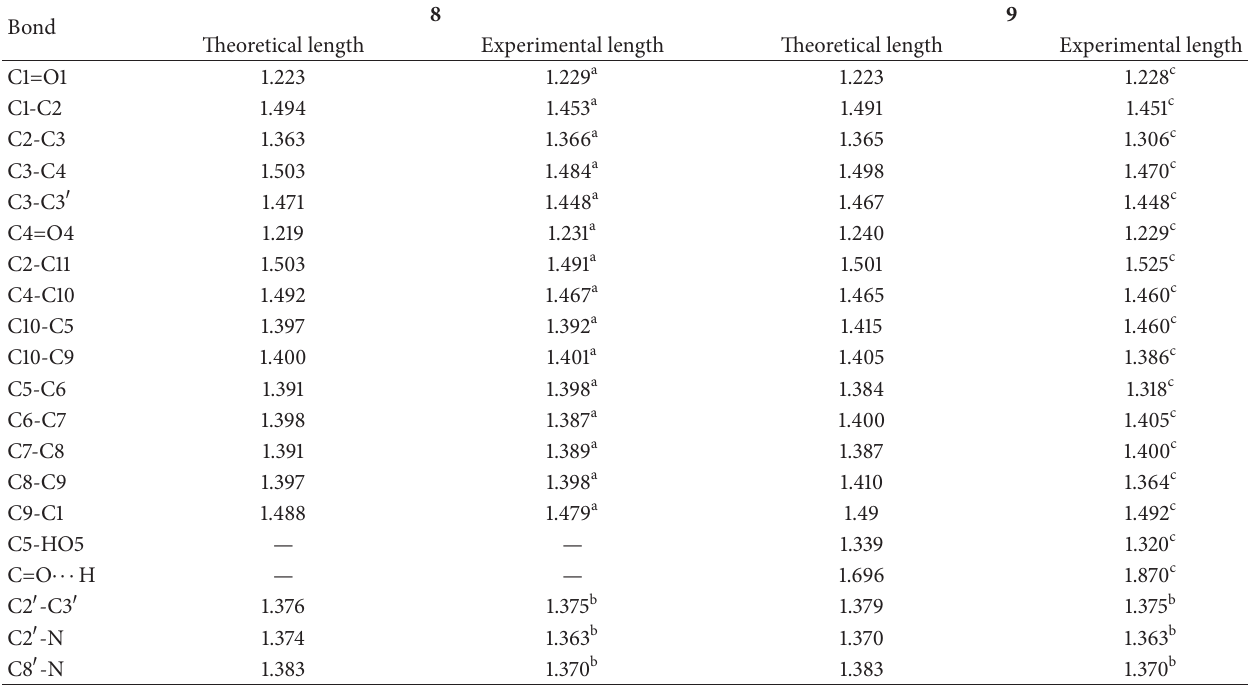
Table 3: Theoretical and experimental selected bond length (in ˚A) of 8 and 9